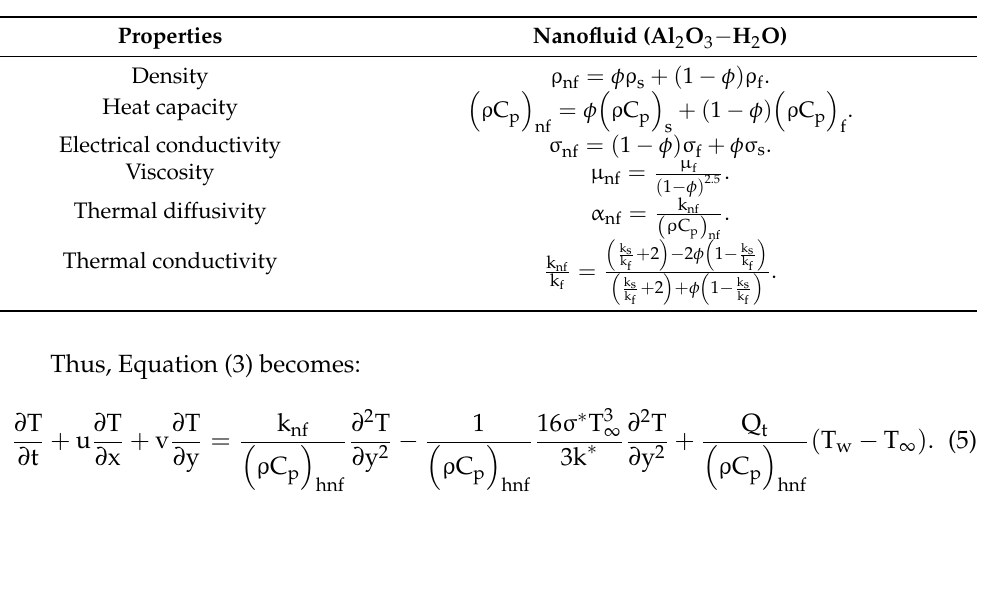
Figure 1. Physical representation and coordinate system. Table 2. The thermophysical properties of Al 2 O 3 − H 2 O in mathematical expressions